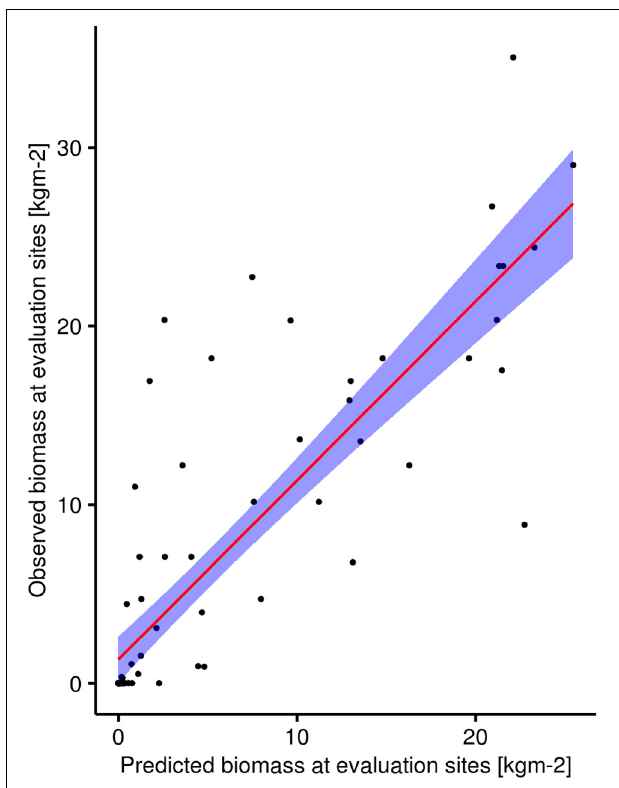
FIGURE 7 | Plot showing the correlation between observed biomass of Laminaria hyperborea in the field at sites in the independent evaluation dataset and the predicted biomass at these sites by the model containing the predictors bottom wave exposure, depth, and proportion hard substrate. Red line is the line of best fit and the shaded blue area represent 95% confidence intervals.